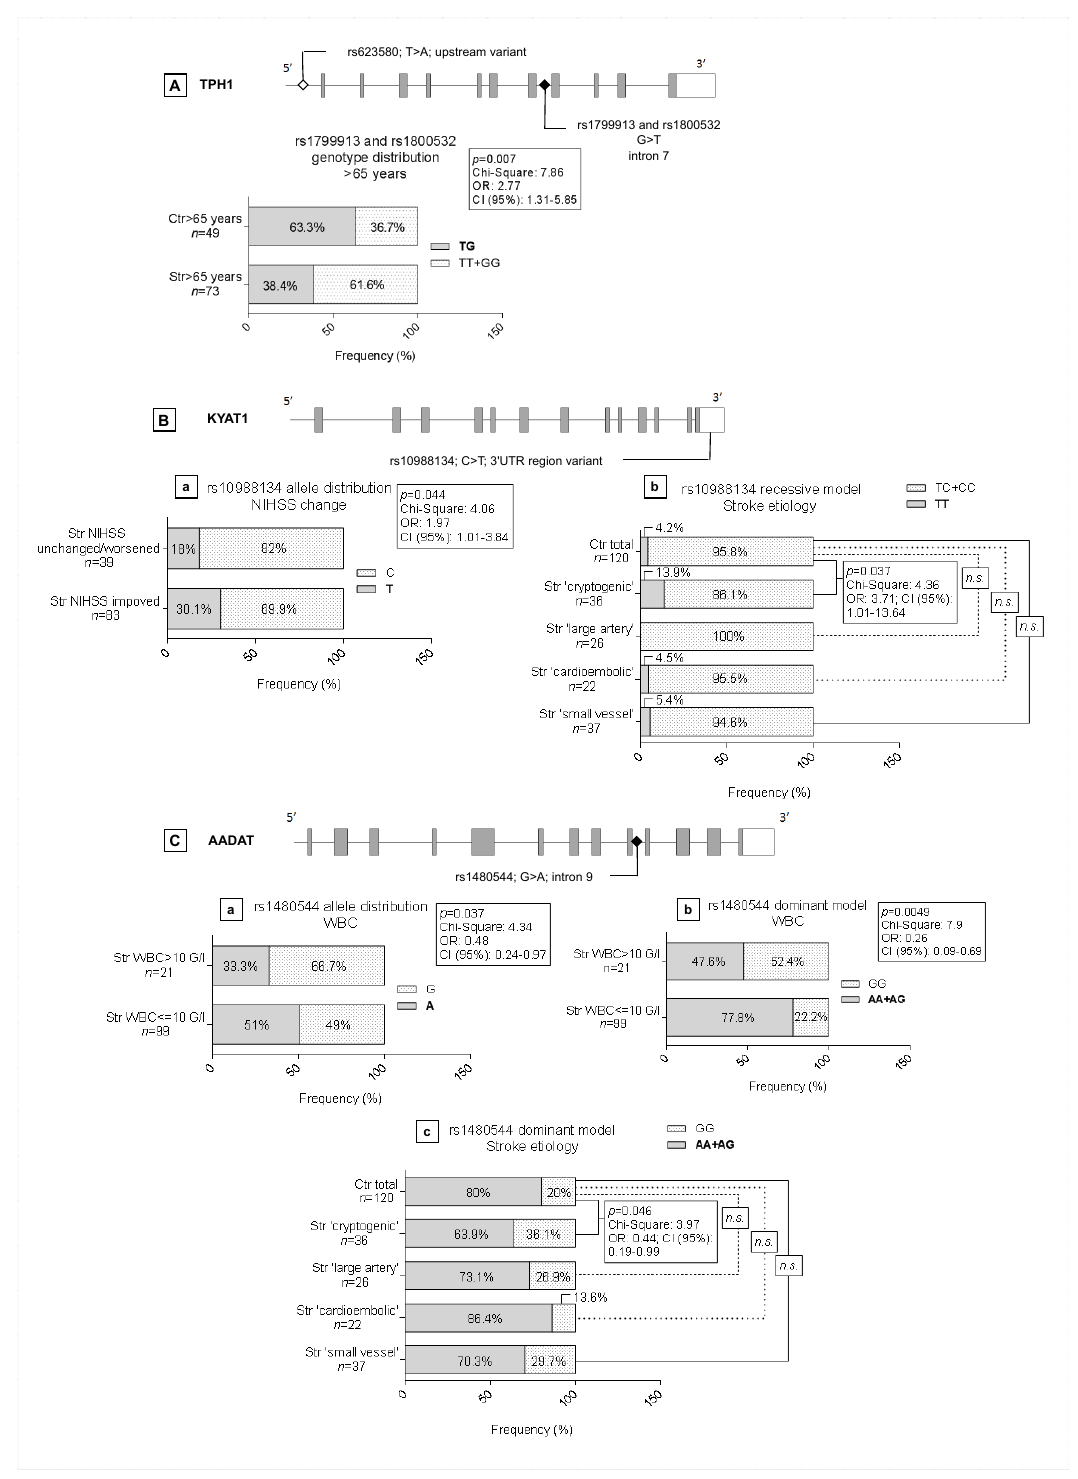
Figure 2. Detected significant differences in the frequencies of studied TPH1 ( A ), KYAT1 ( B ) and AADAT ( C ) gene variants. Gene structures are illustrated with grey boxes indicating exons and small rhombuses the positions of SNPs studied. Graphs of allele frequencies are shown only for comparisons of groups and subgroups of stroke patients and controls where significant differences were detected ( a – c ), as indicated by statistical data in boxes. For a detailed description please see the text. Abbreviations: TPH1: tryptophan hydroxylase 1; Ctr: control; Str: stroke; OR: odds ratio; CI: confidence interval; KYAT1: kynurenine aminotransferase 1; NIHSS: NIH Stroke Scale; UTR: untranslated region; AADAT: kynurenine/alpha- aminoadipate aminotransferase; WBC: white blood cell; n.s.: